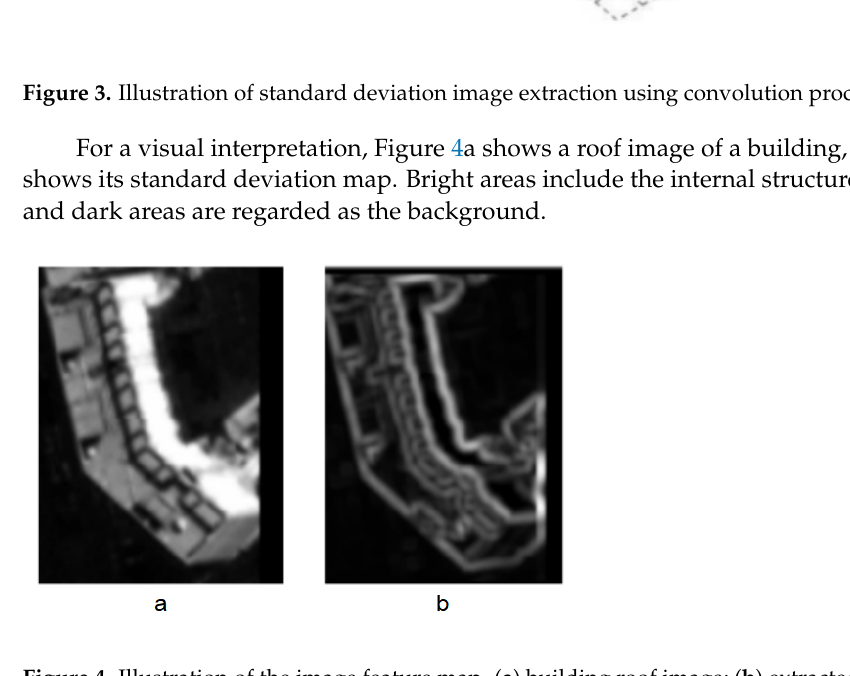
Figure 4. Illustration of the image feature map. ( a ) building roof image; ( b ) extracted feature